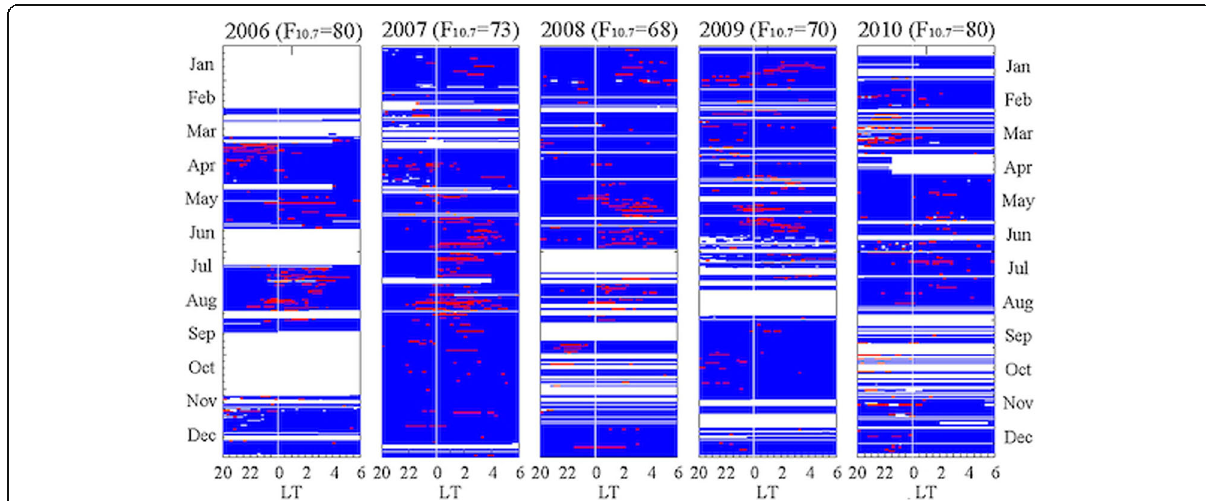
Fig. 3 Seasonal and local time variations in the F -region FAI echoes observed at Kototabang, Indonesia from 2006 to 2010. A signal-to-noise ratio larger than 0 dB was regarded to be an echo from an FAI. Red and blue sections represent FAI occurrences and non-occurrences, respectively, against local time and day of the year for each year from 2006 to 2010. The yearly average of the solar flux F10.7 is given at the top of each panel (after Nishioka et al. 2012)